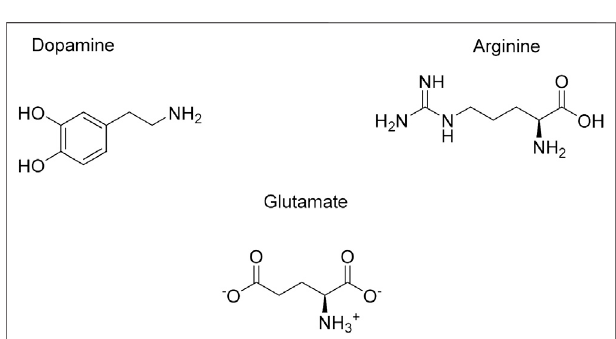
FIGURE 10 | Endogenous small molecules affecting α Syn conformation and